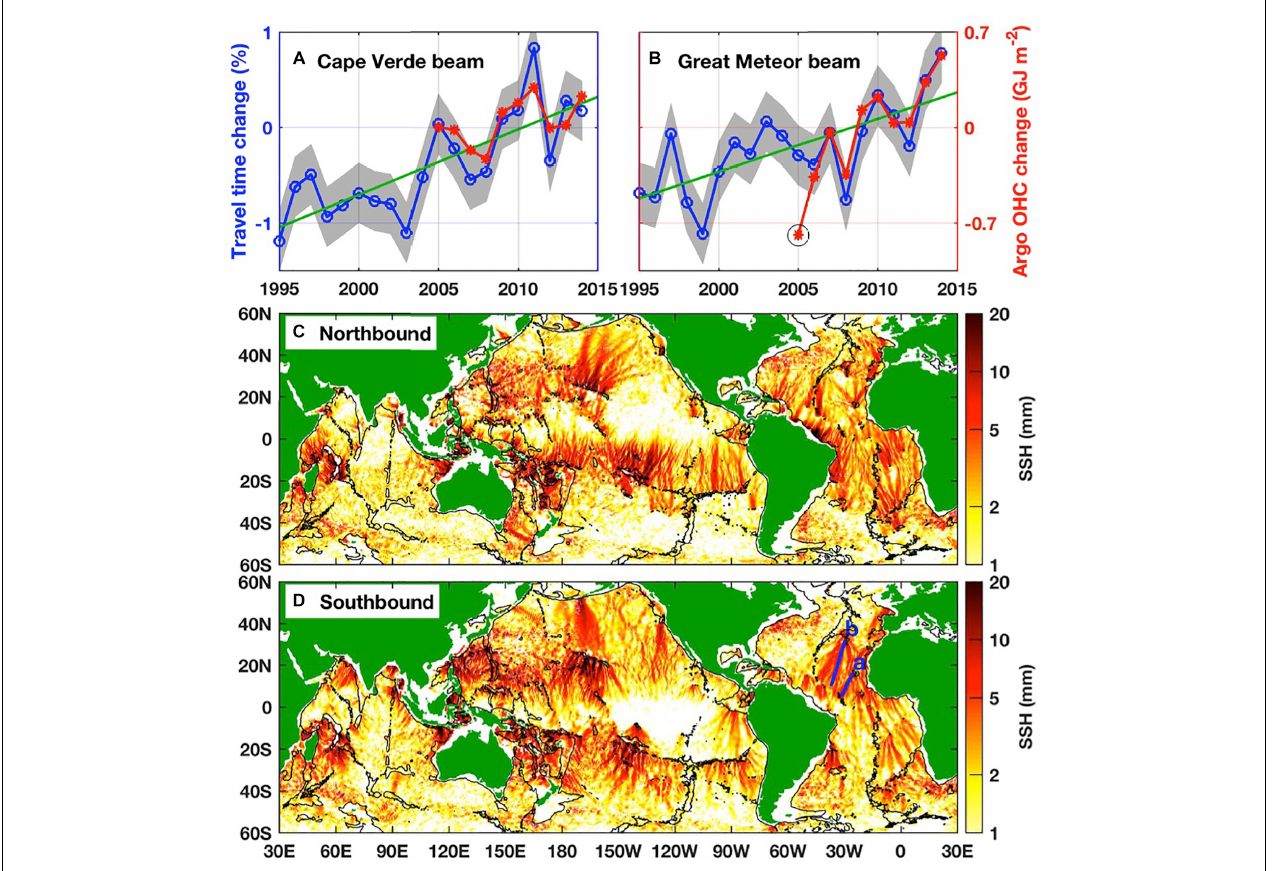
FIGURE 5 | Internal tide oceanic tomography. (A,B) Travel time changes in percentage during 1995–2014 along mode-1 M2 internal tidal beams from (A) Cape Verde Islands and (B) Great Meteor Seamount. See panel (D) for beam locations. Both beams reveal significant interannual variations and bidecadal trends in the travel time change. Argo-measured OHC changes are overlapped with a conversion rate of 1% versus 0.7 GJ/m2 as explained in the text. (C,D) Global mode-1 M2 internal tides from 20 years of satellite altimeter data. The northbound (propagation direction ranging 0 ◦ –180 ◦ ) and southbound (180 ◦ –360 ◦ ) components have been separated. OHC changes can be monitored by tracking long-range internal tidal